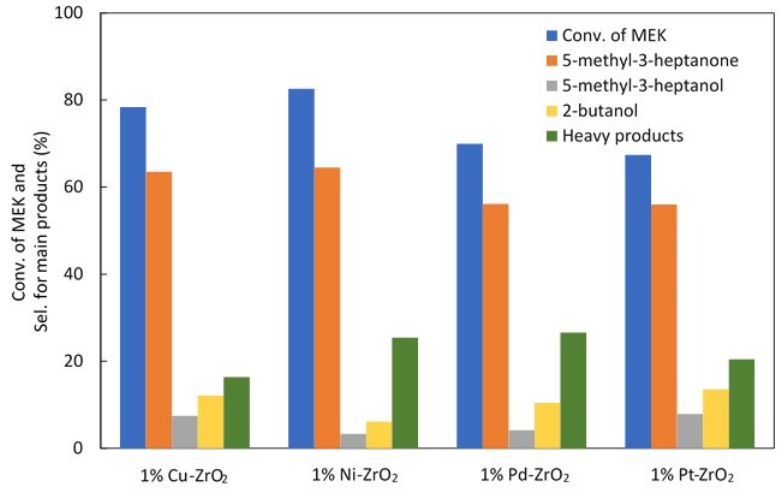
Figure 8. Catalytic results for the conversion of MEK to a variety of products over different catalysts. Reaction conditions: catalyst weight, 1.0 g; feed rate of MEK, 1.0 mL/h; H 2 /MEK molar ratio, 2; reaction temperature, 180 ◦ C; space time, 89 g mol − 1 h. Heavy products include C 12 ketone, C 12 alcohol, condensation products, and so